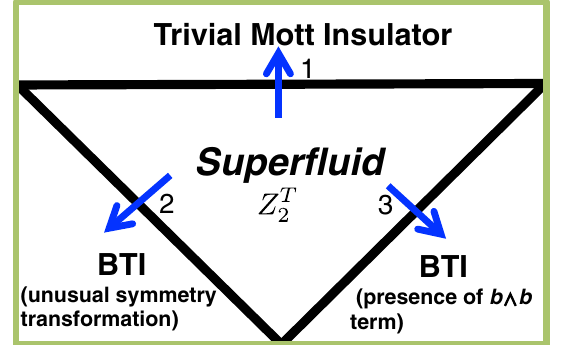
FIG. 1. Phases obtained by vortex-line condensation. In the phase transition 1, U(1) symmetry (i.e., boson number conser- vation) is restored from superfluid to a trivial Mott insulator by condensing strings (i.e., 2 π vortex lines). Thus, the trivial Mott insulator phase is formed by vortex-line condensation with b ∧ da -type bulk field theory description. In the phase transition 2, strings are also condensed and the bulk field theory is also b ∧ da type (see Secs. VI and VII), but the resultant Mott phase is a nontrivial SPT state [i.e., bosononic topological insulator (BTI)] since either U(1) or Z T 2 symmetry transformation is defined in an unusual way. Thus, we end up with two different BTI root states. In the phase transition 3, strings are condensed in the presence of a nontrivial linking Berry phase term, or more precisely, a nontrivial multicomponent b ∧ b -type term. The nontrivial Mott phase is a BTI phase obtained in Sec. V, which is a SPT root state beyond group cohomology classification and supports “ all-fermion ” Z 2 surface topological order. Here, Z T 2 denotes time-reversal symmetry with T 2 ¼ 1